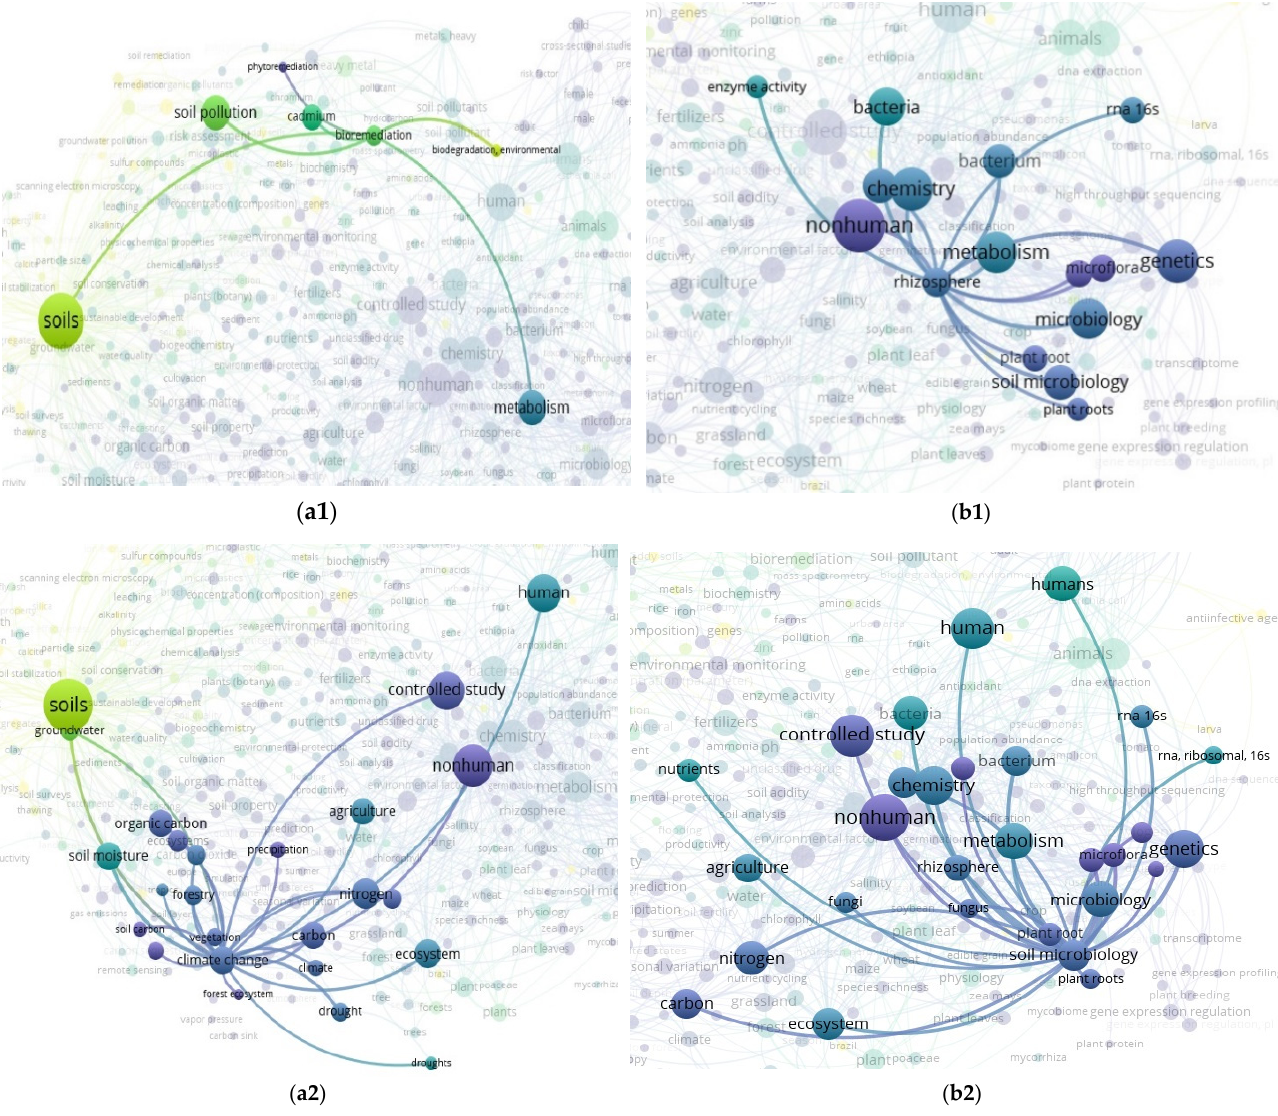
Figure 3. Analyzing Scopus soil results with the VOSviewer. The bioremediation, climate change, rhizosphere and the soil microbiology paradigm. ( a1 ) Bioremediation is associated with soil pollution and metabolism. ( b1 ) Rhizosphere is associated with chemistry, metabolism, microbiology. ( a2 ) Climate change is associated with soils, ecosystem, organic carbon, human. ( b2 ) Soil microbiology is associated with chemistry, metabolism, agriculture human(s), ecosystem, nutrients, bacteria, fungi, carbon and nitrogen.